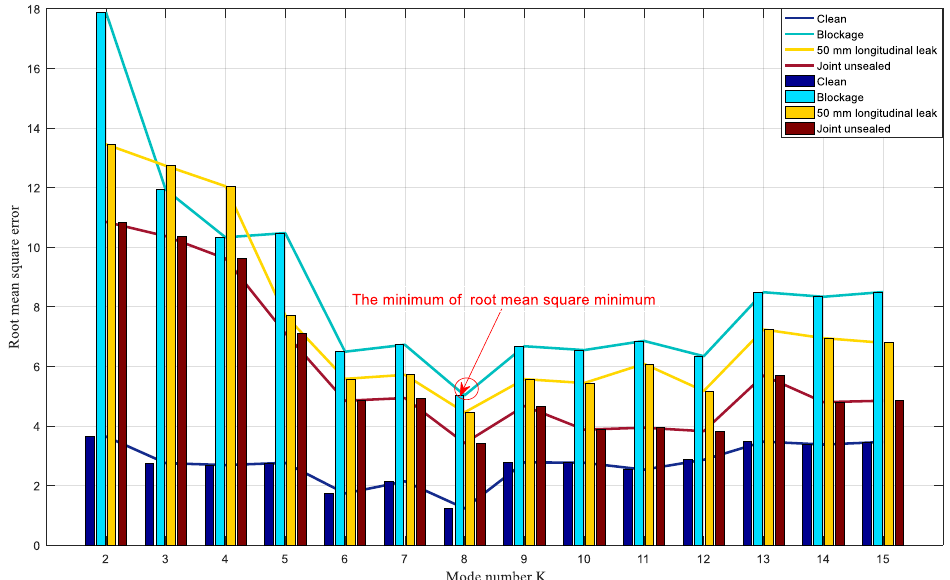
Figure 8. Root mean square error of four conditions in the siphon for different mode number K.